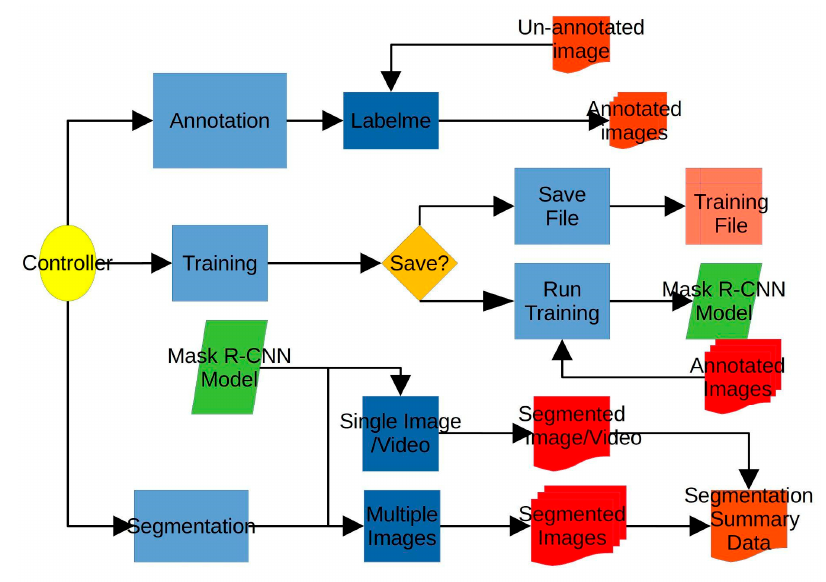
Figure 1. Controller module ( a ) showing options when selecting annotation ( b ), training ( c ), and segmentation ( d ).